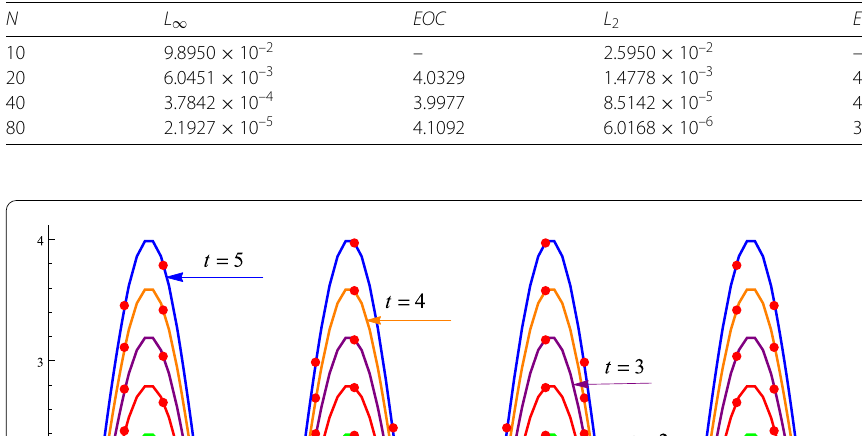
Figure 1 Approximate solution for Problem 1 at different time levels when (cid:2) t = 0.001, N = 80, α = 1.75